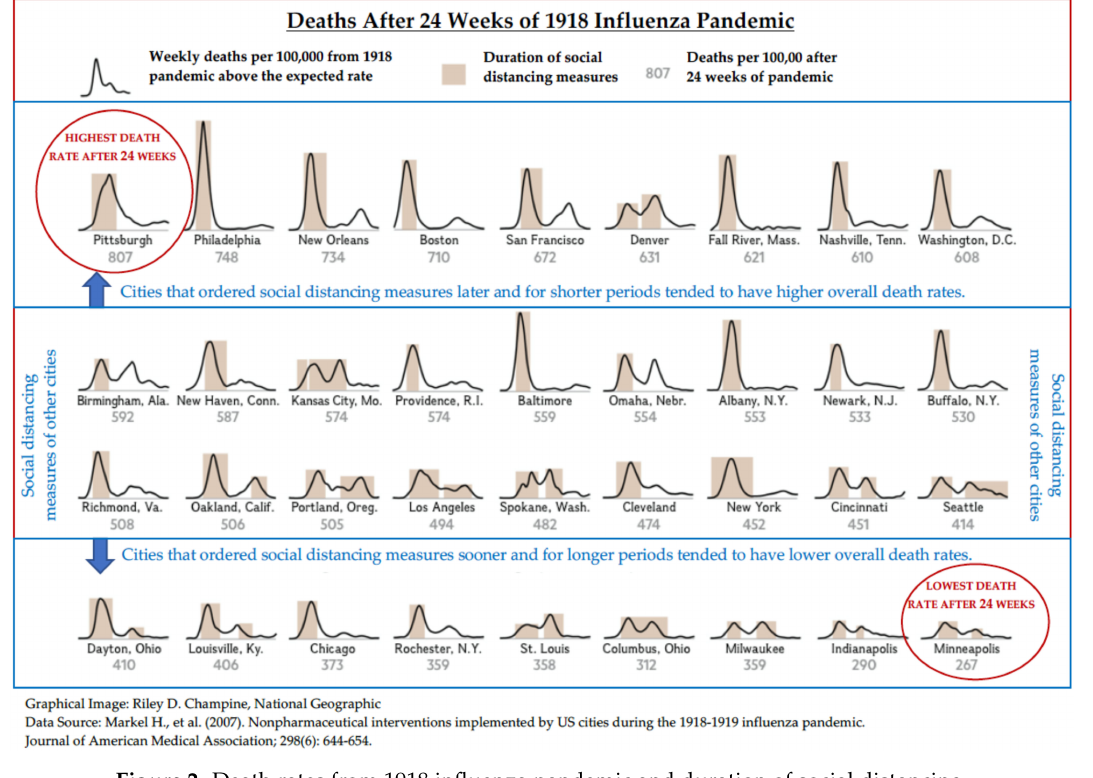
Figure 2. Death rates from 1918 influenza pandemic and duration of social